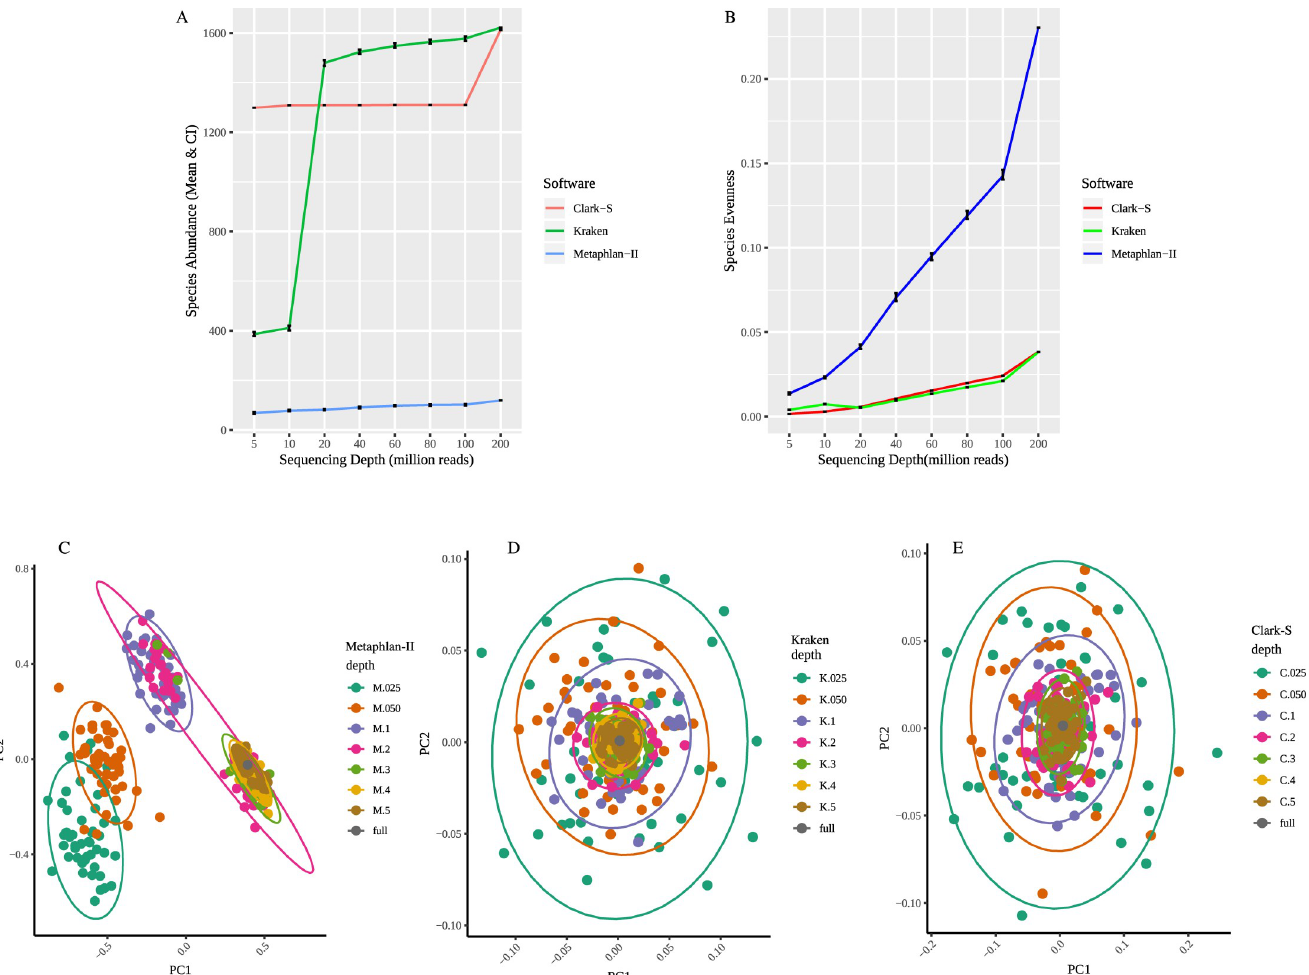
Fig 5. Species diversity prediction as dependent on sequencing depth. A. Species richness for different taxonomy classification approaches. Species richness is shown as mean values and 95% confidence intervals as dependent on different sequencing depths. B . Species evenness for different taxonomy classification approaches as dependent on different sequencing depths. Principle Component Analysis results for abundances of species identified by C Metaphlan-II, D Kraken, and E Clark-S. First two principal components are shown in scores